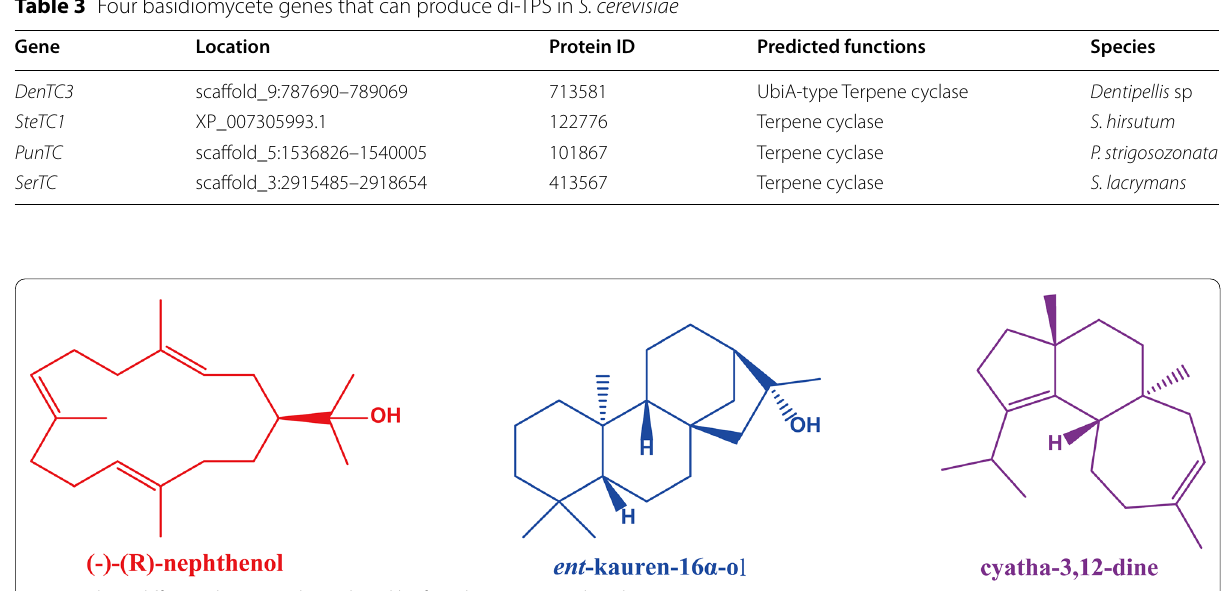
Fig. 6 Three different diterpenoids produced by four di-TPS genes in basidiomycetes in S.